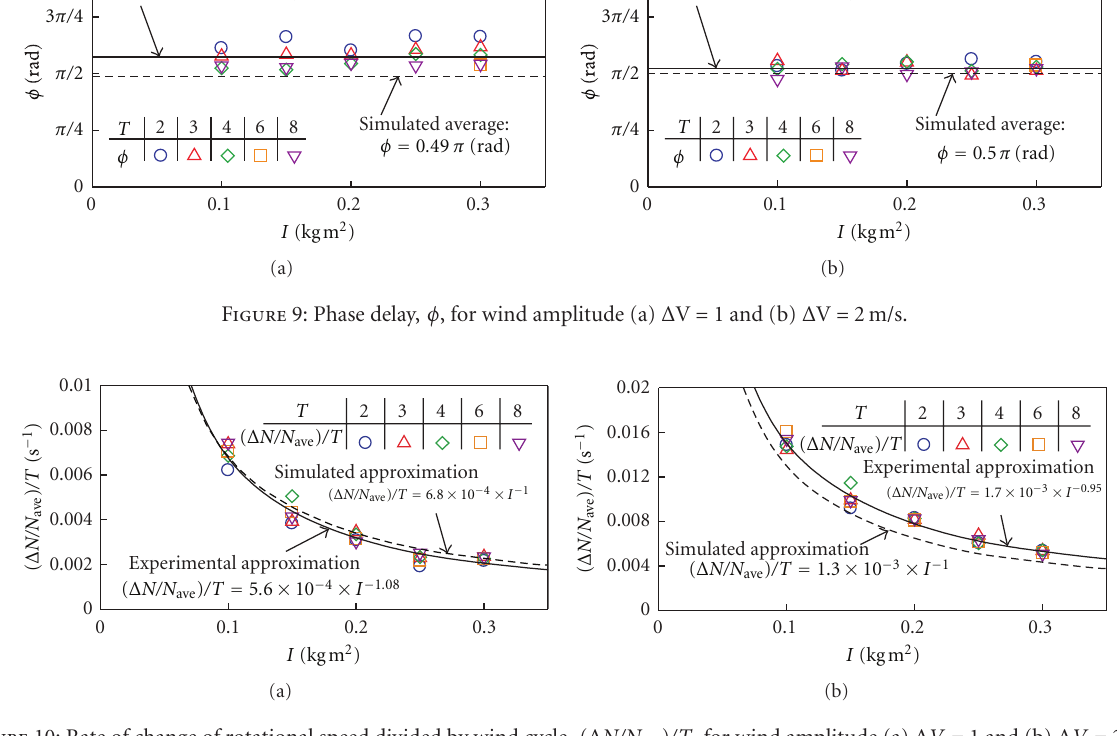
Figure 10: Rate of change of rotational speed divided by wind cycle, ( Δ N/N ave ) /T , for wind amplitude (a) Δ V = 1 and (b) Δ V = 2m/s.